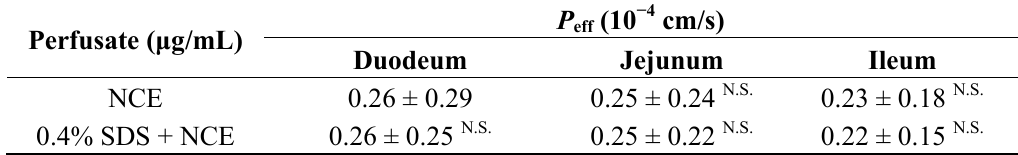
Table 3. The effect of 0.4% sodium dodecyl sulfate on intestinal absorption of NCE using single-pass intestinal perfusion method. The data were presented as mean ± SD ( n = 3 for each group).